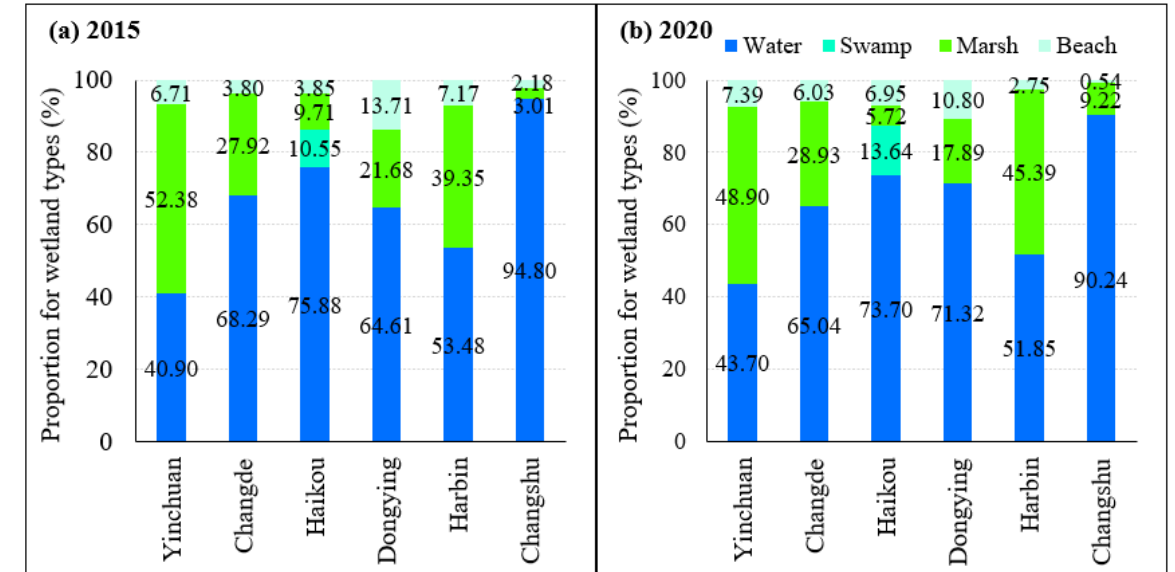
Figure 11. Wetland proportion for wetland types for 6 cities in 2015 ( a ) and 2020 ( b ).